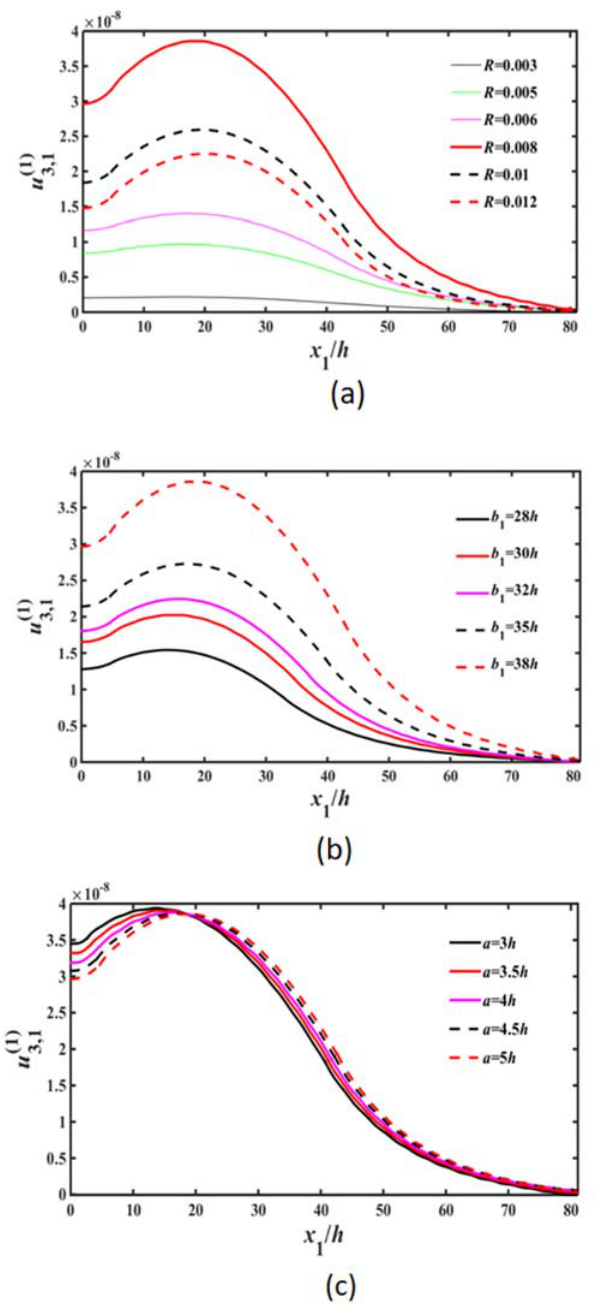
Figure 7. Effects of electrode parameters on TT 1 strain distribution. ( a ) Electrode mass ratio R . ( b ) Electrode width b 1 . ( c ) Electrode gap a .